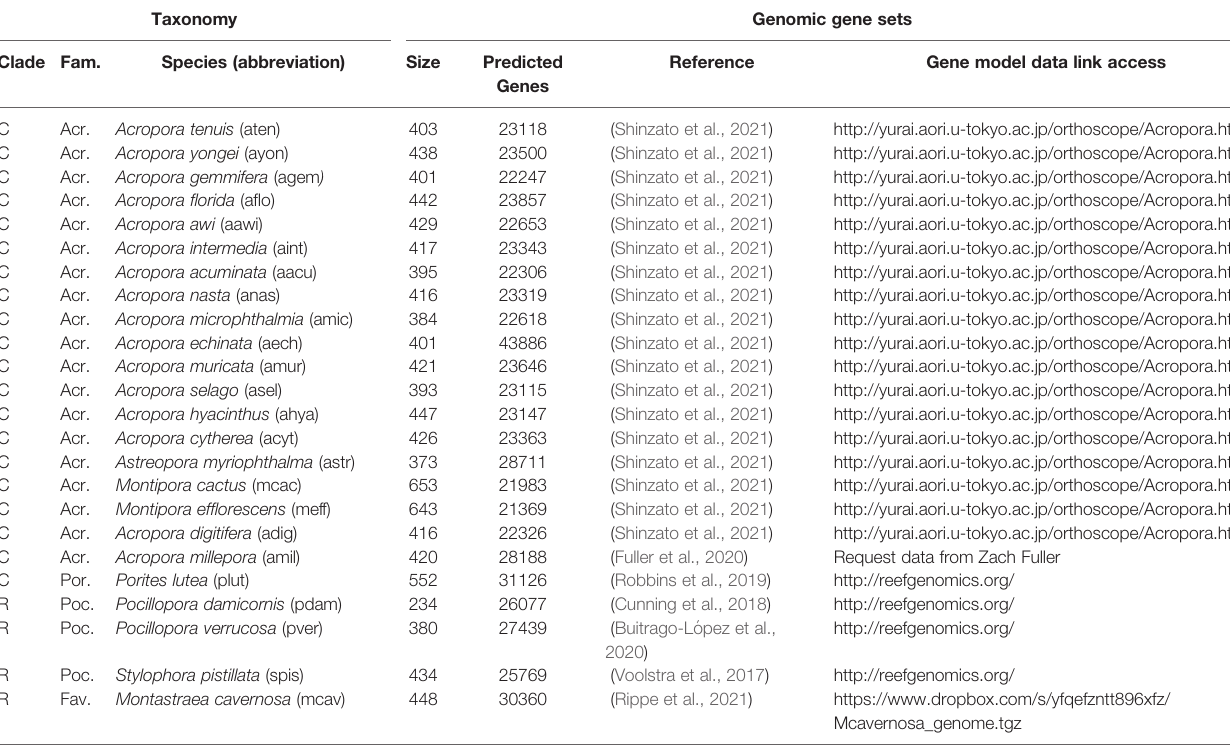
TABLE 1 | Coral genomic gene sets used for the OrthoFinder analysis.